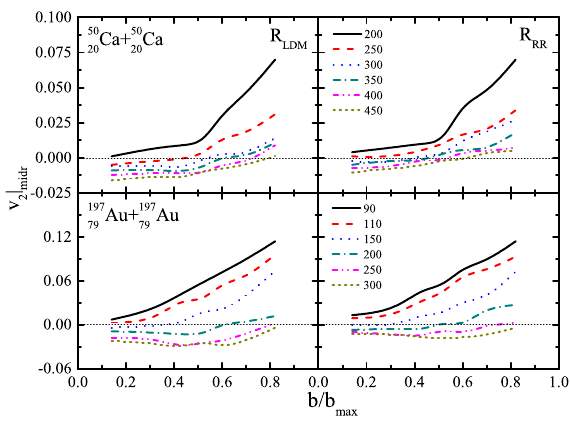
Figure 2. Same as in Fig. 1, but for elliptical flow v 2 .